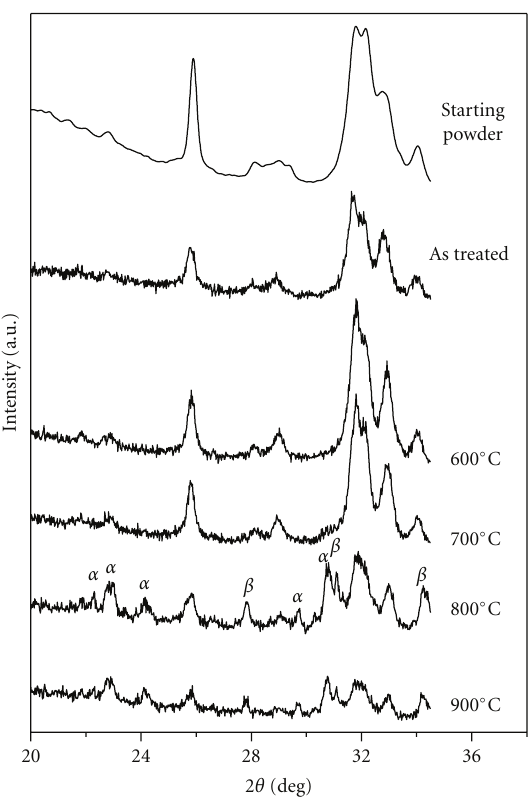
Figure 9: XRD patterns of HA deposited on Ti substrate after heated at various